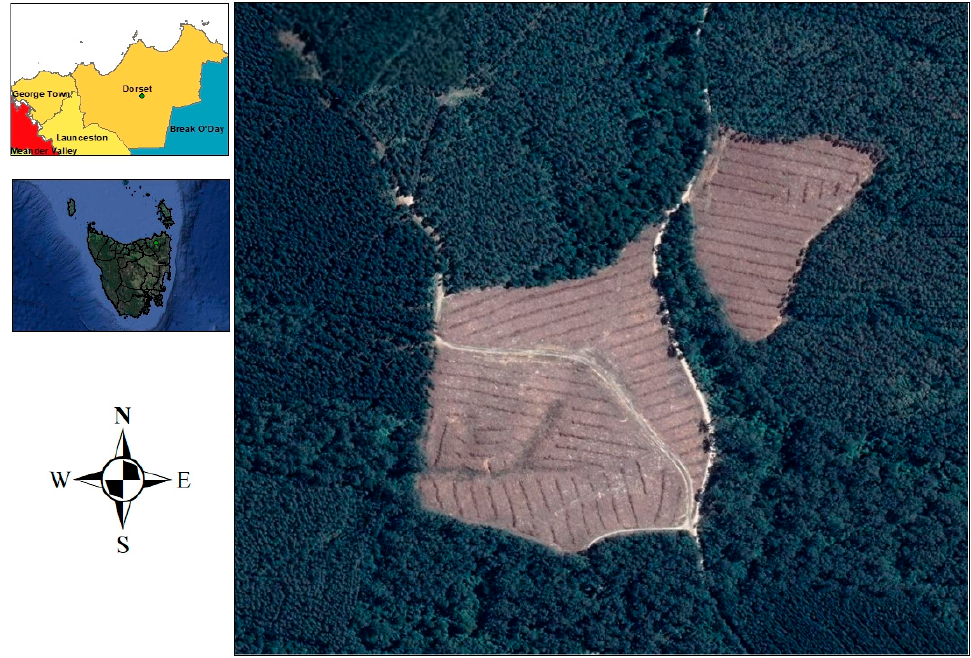
Figure 1. Case study area located in the Dorset region, Tasmania.